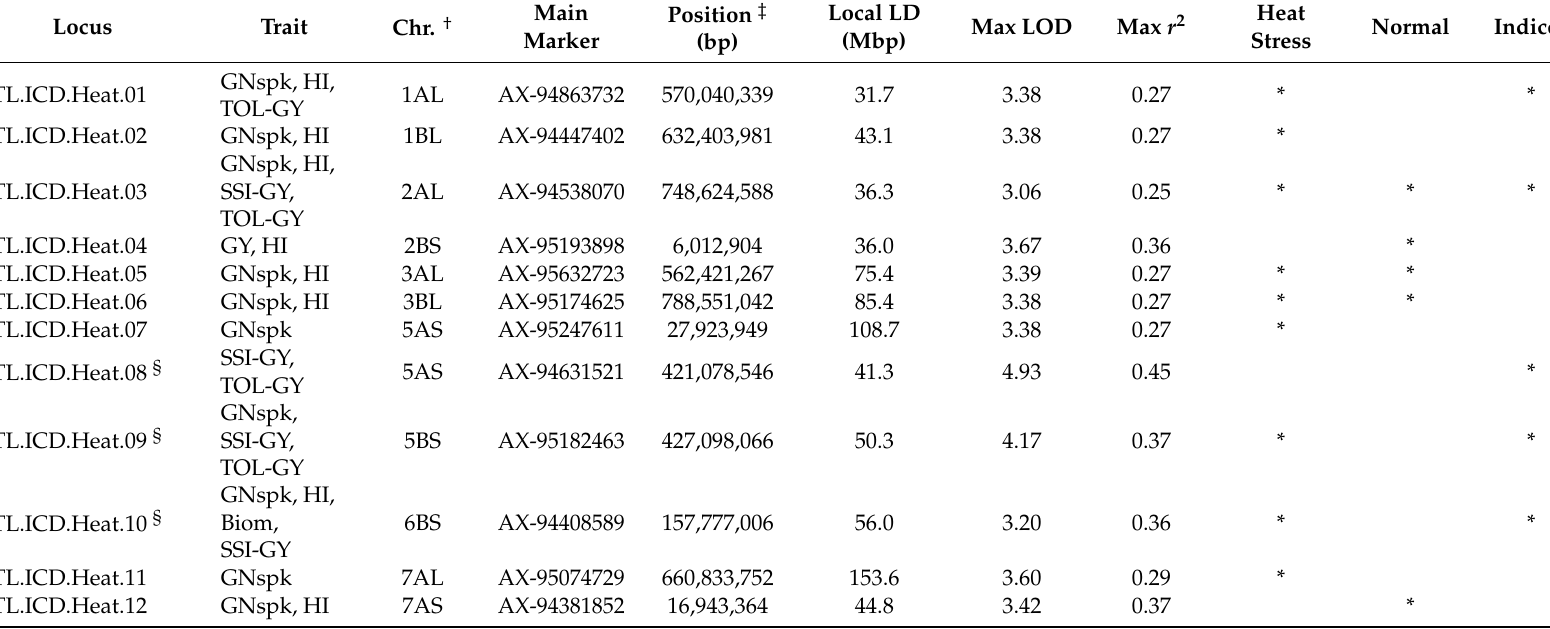
Heat Normal Indices Stress